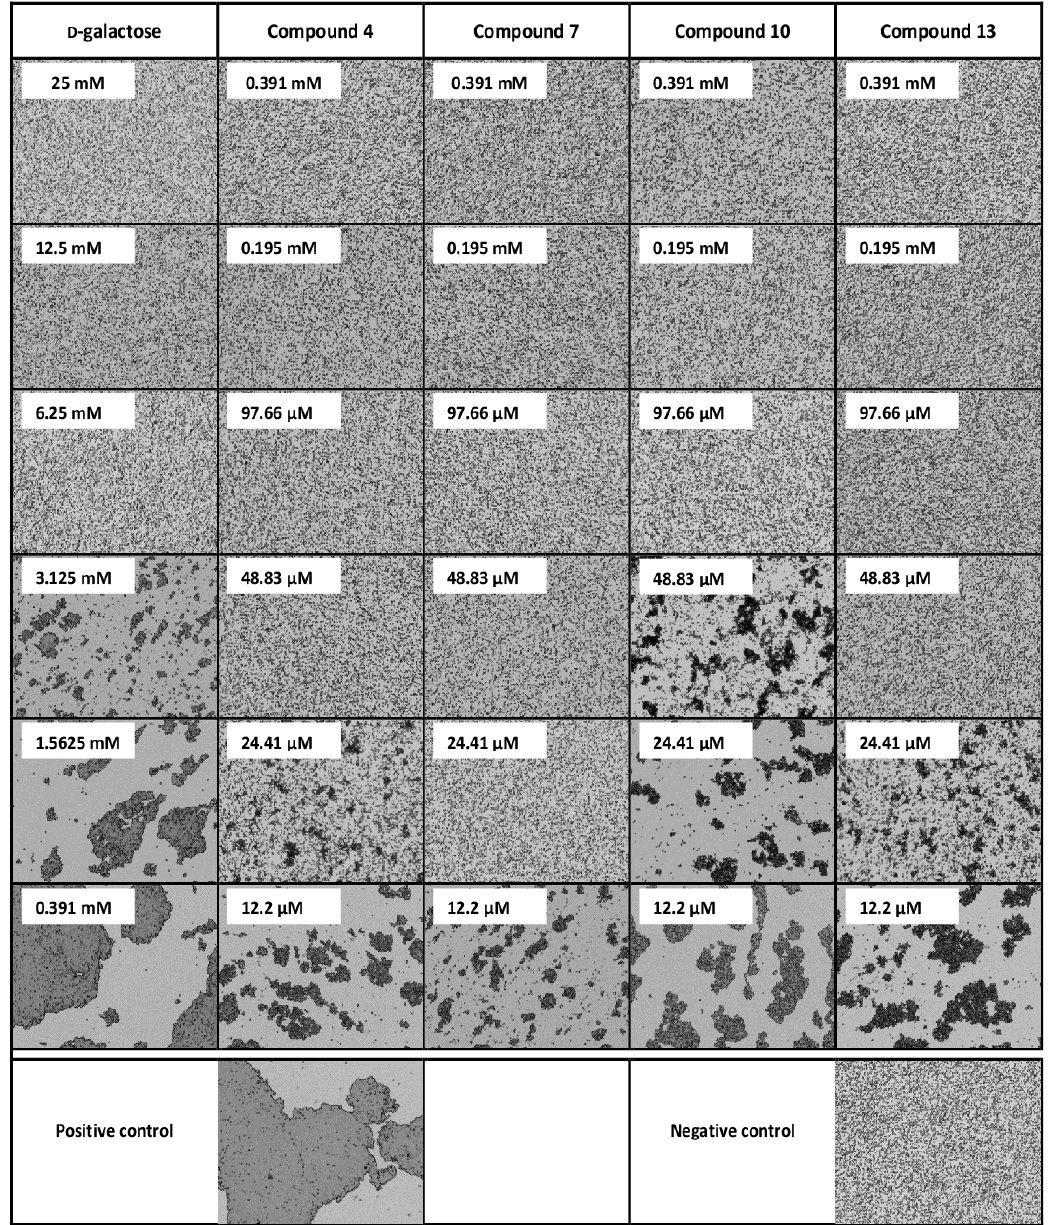
Figure 2. Influence of D -galactose, compounds 4 , 7 , 10 , and 13 on hemagglutination caused by lectin PA-IL. Positive control: experiment without inhibitor. Negative control: experiment without lectin PA-IL.